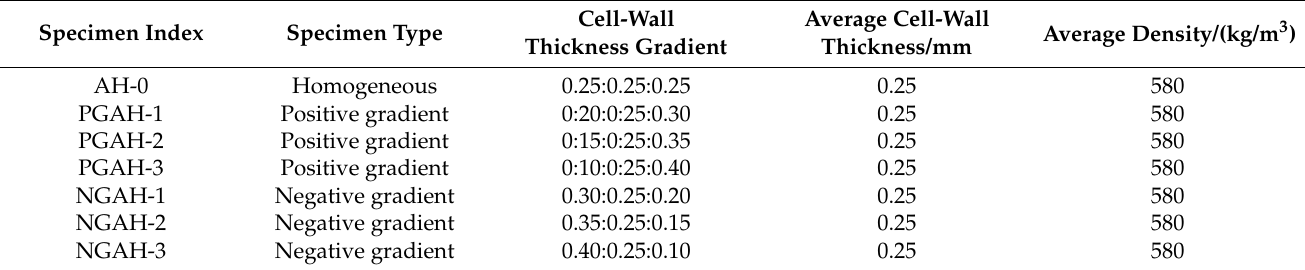
Table 3. The parameters of different specimens in the numerical simulation.